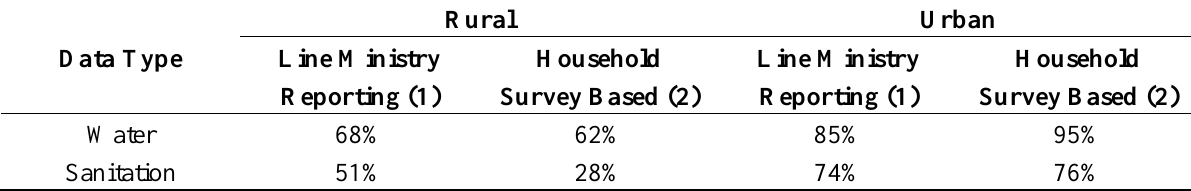
Table 5. Comparison of global coverage estimates derived from line ministry (―provider‖) versus household (―user‖)—based data, for 1990.